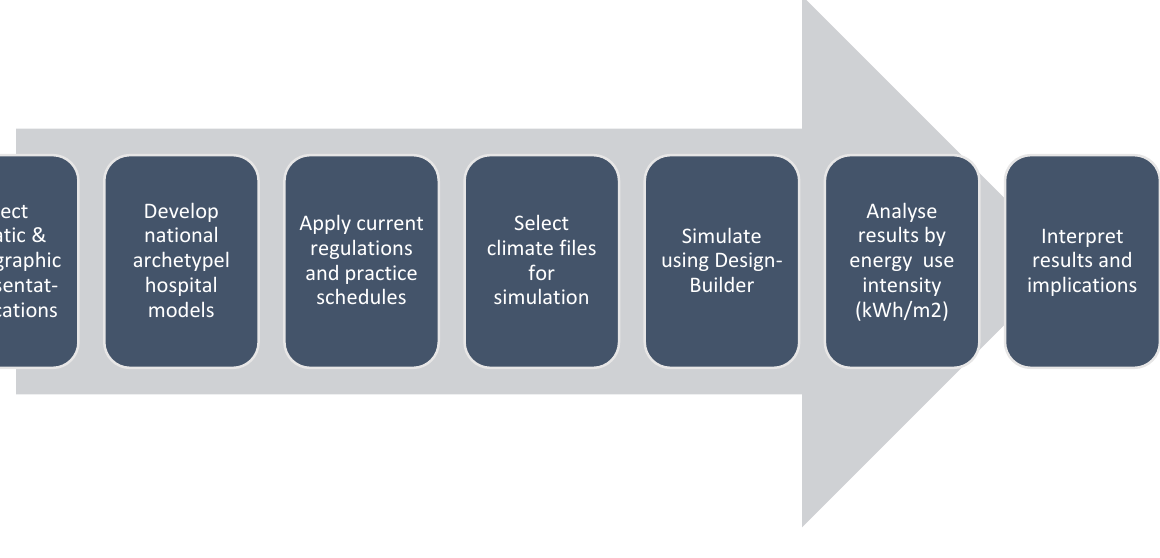
Figure 1. Study methodology.